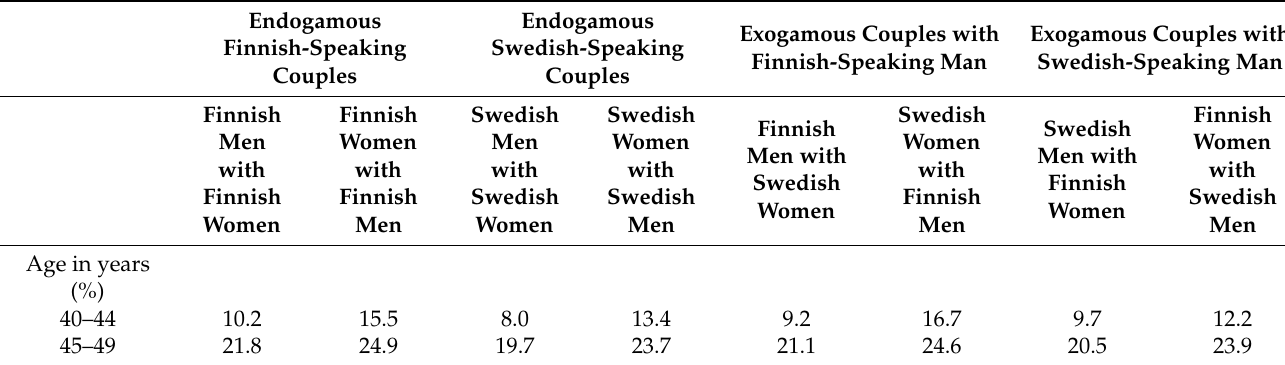
Table 1. Descriptive statistics of the analytic